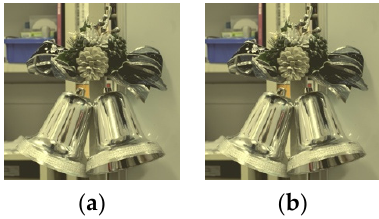
Figure 7. tone mapping function. ( a ) Conventional tone mapping function; ( b ) Proposed tone mapping function.